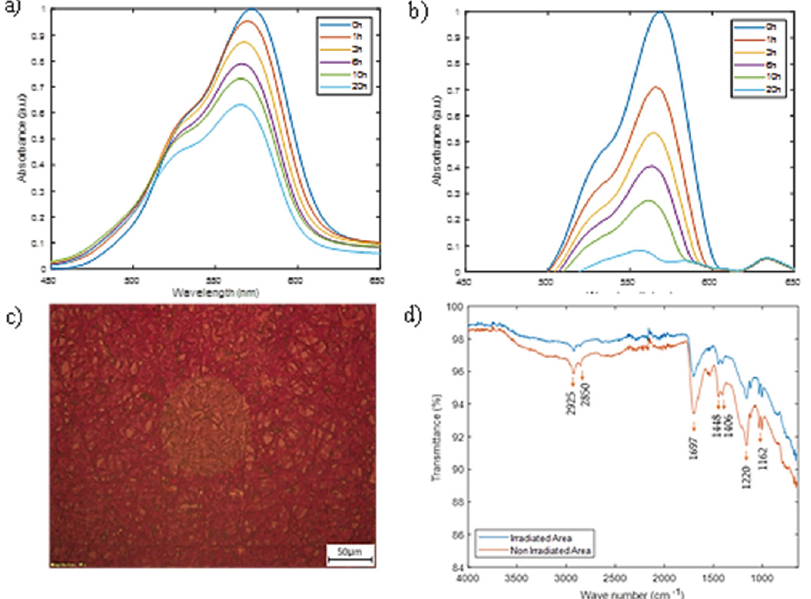
Figure 9. ( a ) Evolution of the degradation rate of RhB deposited into S0 sample S0 for a total irradiation time of 20 h; ( b ) evolution of the degradation rate of RhB deposited into S3 sample for a total irradiation time of 20 h; ( c ) optical microscopy image of a micrometric degraded zone of the dye; ( d ) FTIR spectra of the irradiated and non ‐ irradiated area of Rhodamine B sample.